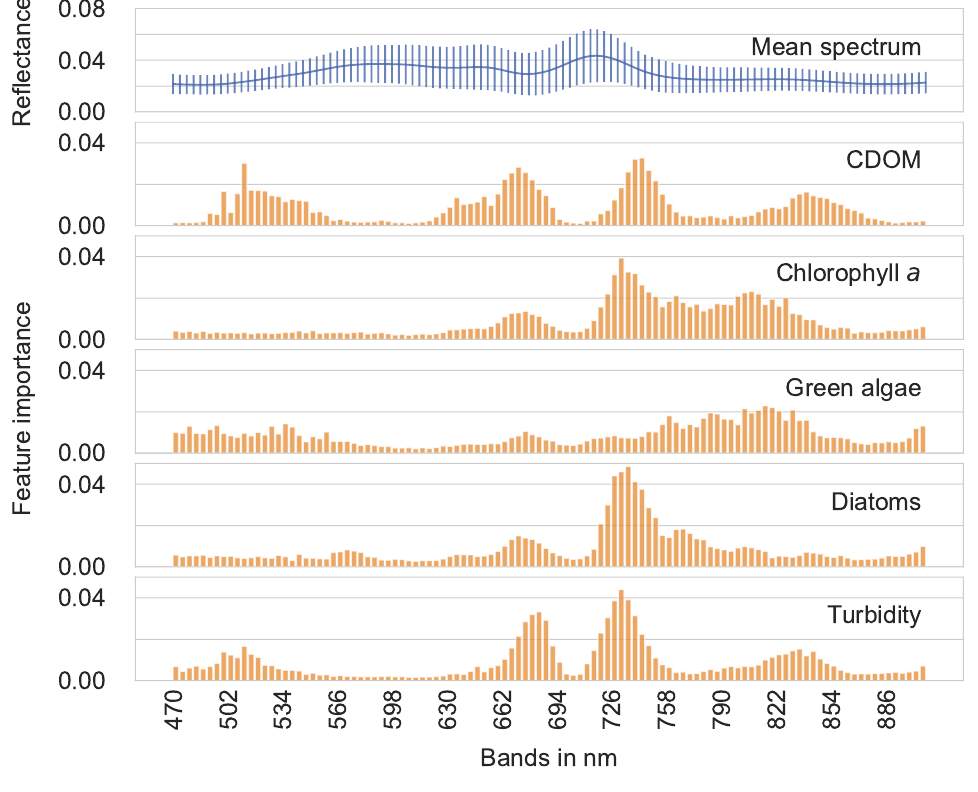
Figure 6. Feature importance of the ET regressor without preprocessing (baseline). The upper plot represents the mean spectrum of the hyperspectral